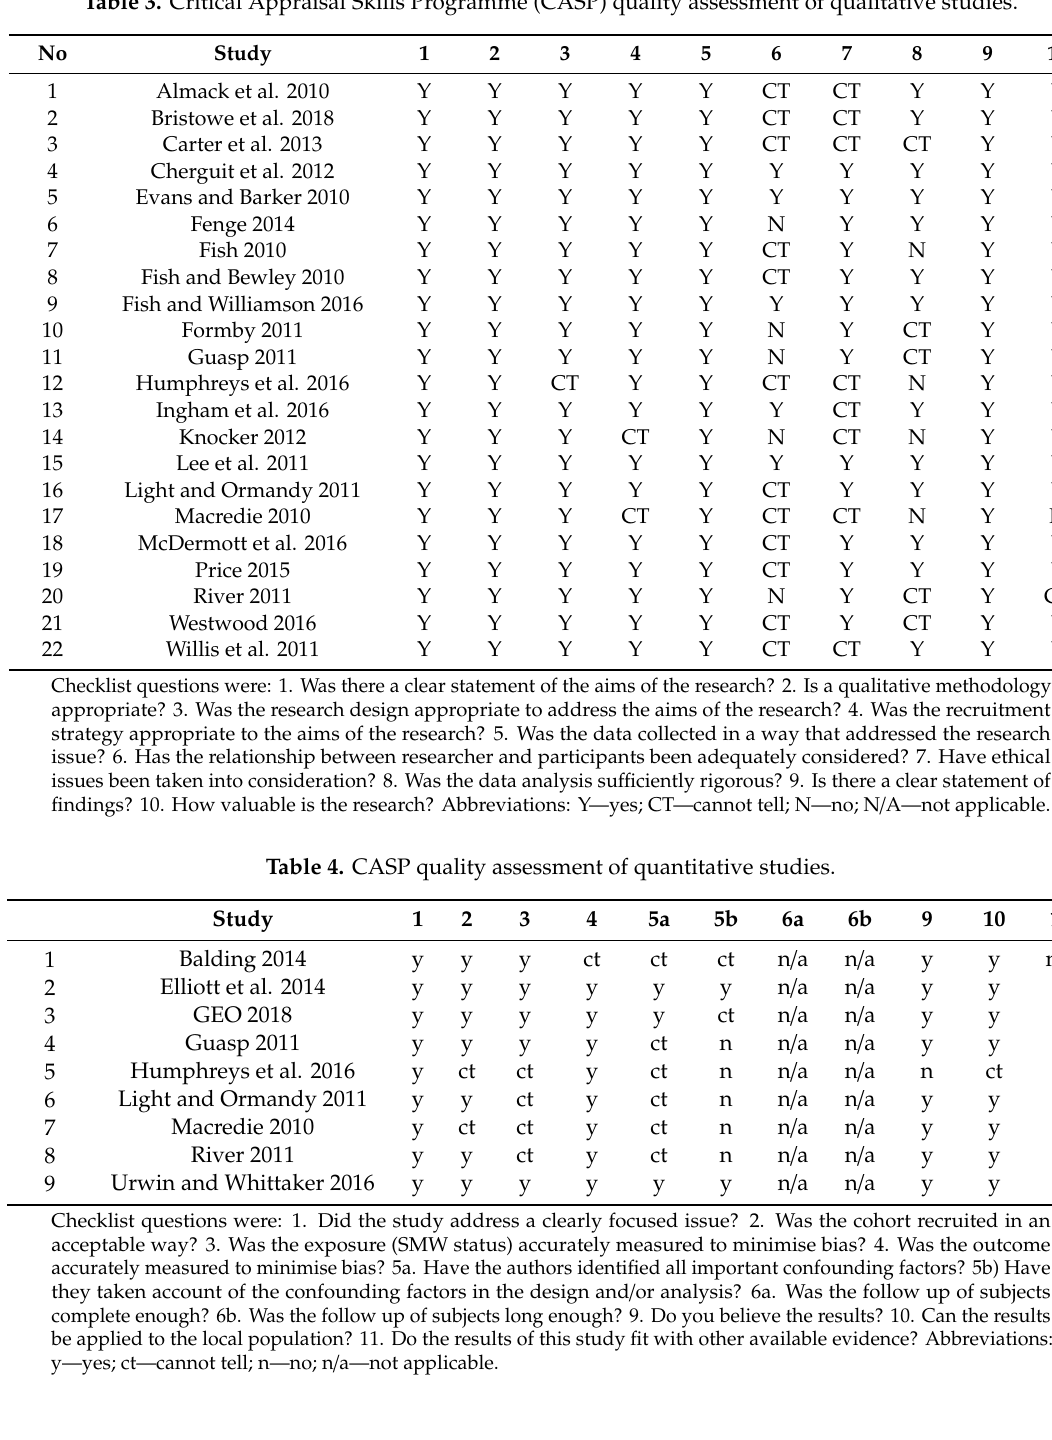
Table 3. Critical Appraisal Skills Programme (CASP) quality assessment of qualitative studies.